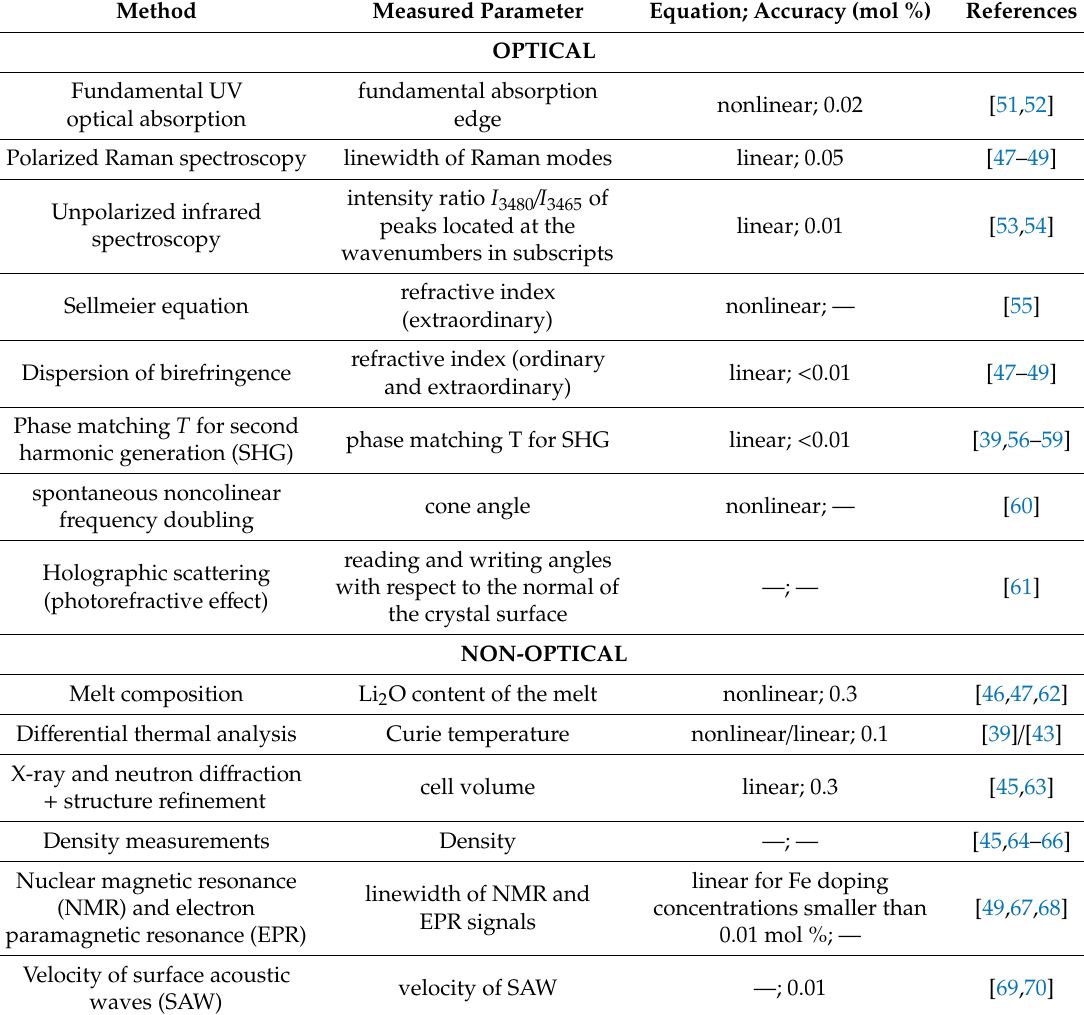
Table 2. Some indirect optical and non-optical methods for the determination of the chemical composition of LN single